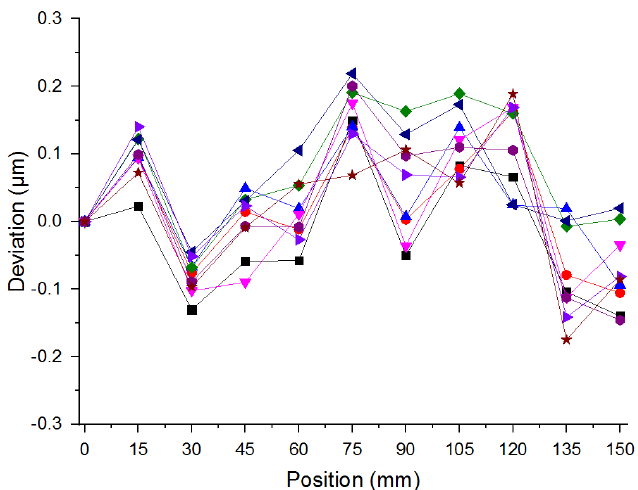
Figure 10. Comparison result between the commercial interferometer and proposed Fabry–Pérot interferometer of PM type.